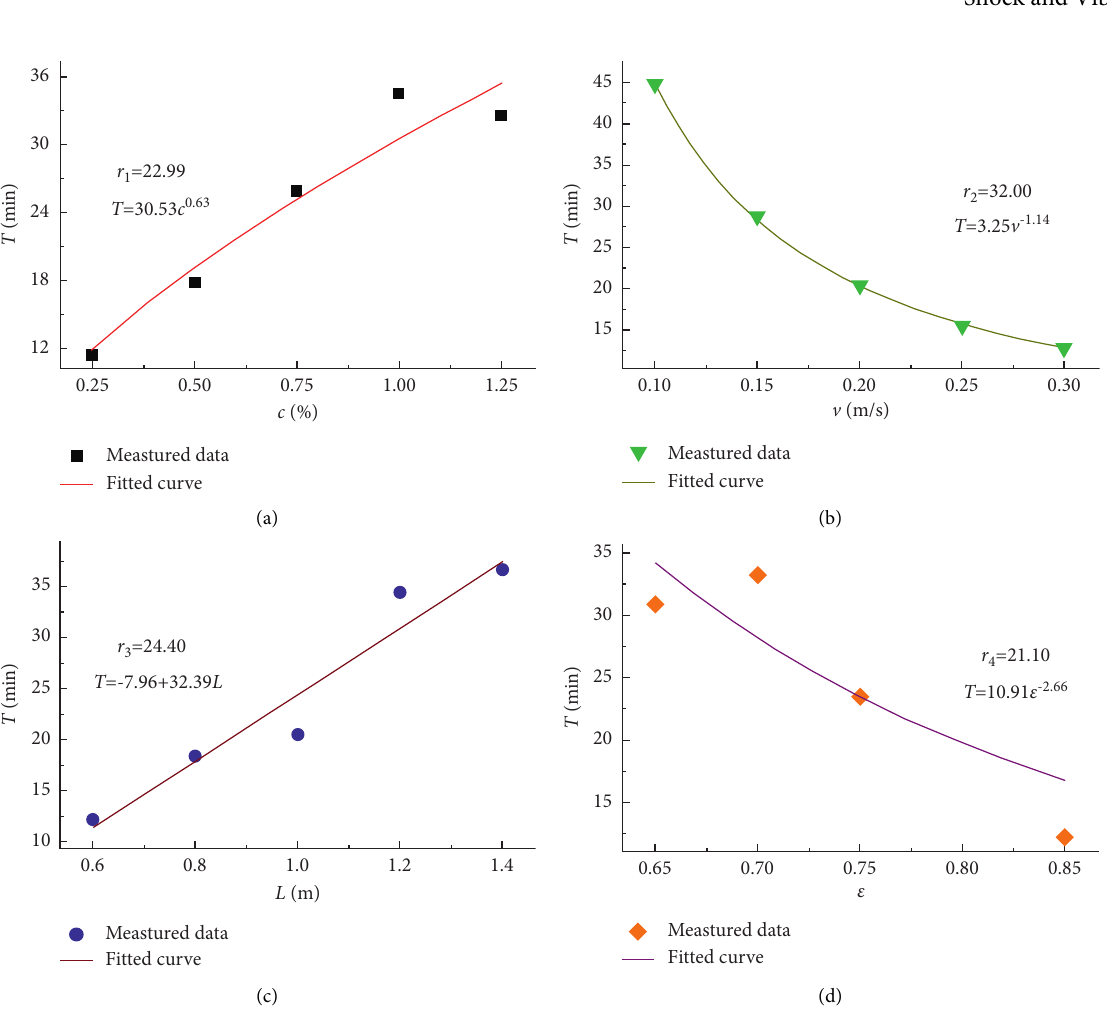
Figure 2: Comprehensive average values and ranges of 4